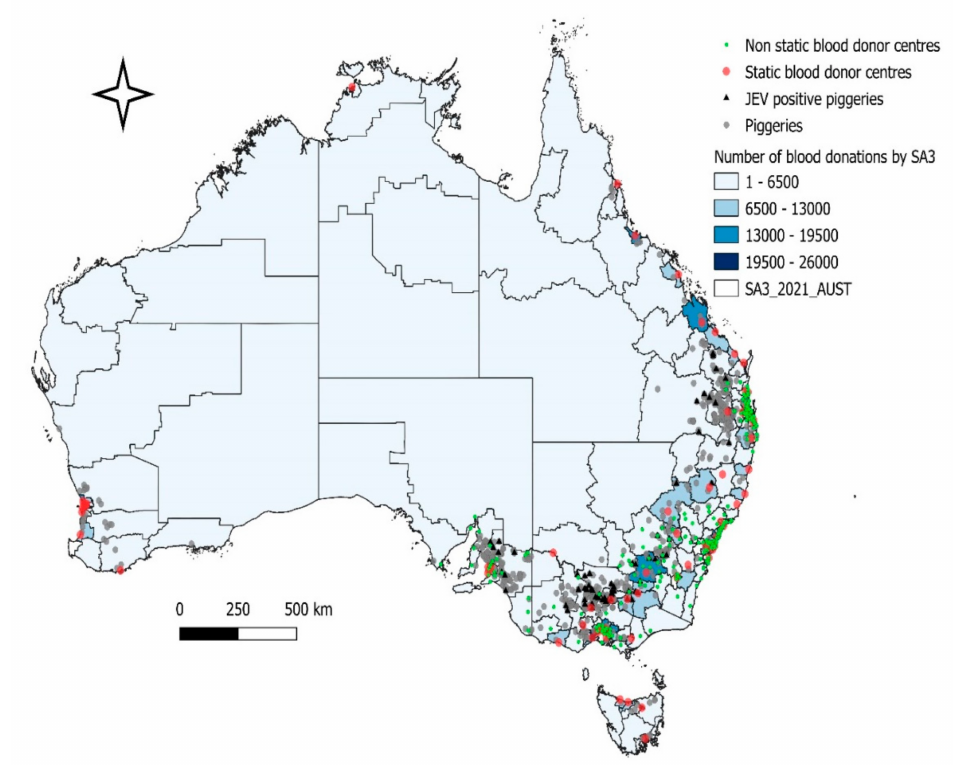
Figure 2. Blood donation centres, number of blood donations (from 1 January 2021 to 25 April 2022) and piggery locations in